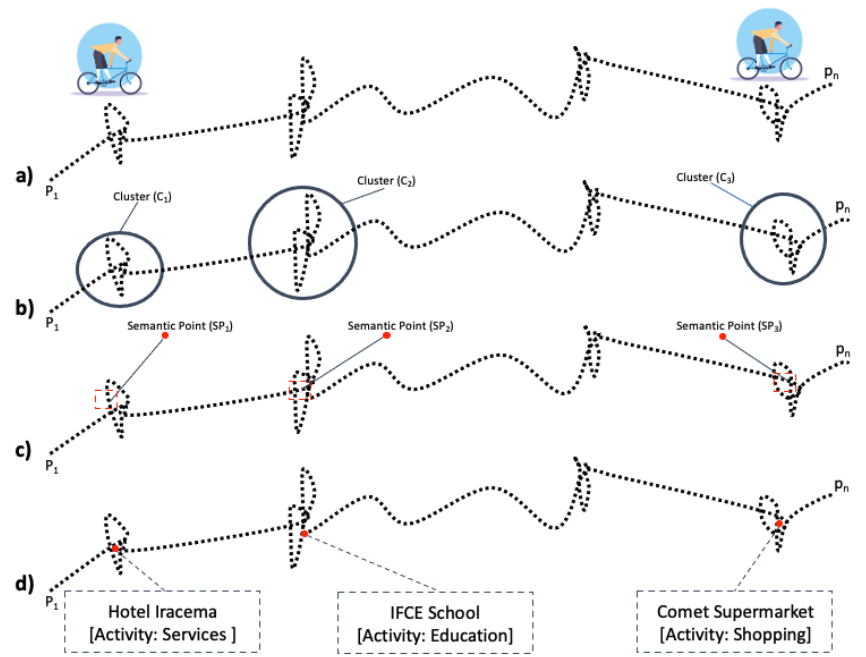
Figure 6. Semantic enrichment: ( a ) Raw trajectory example. ( b ) Computer clusters. ( c ) Semantic point identification. ( d ) Annotation of probable POI visited and